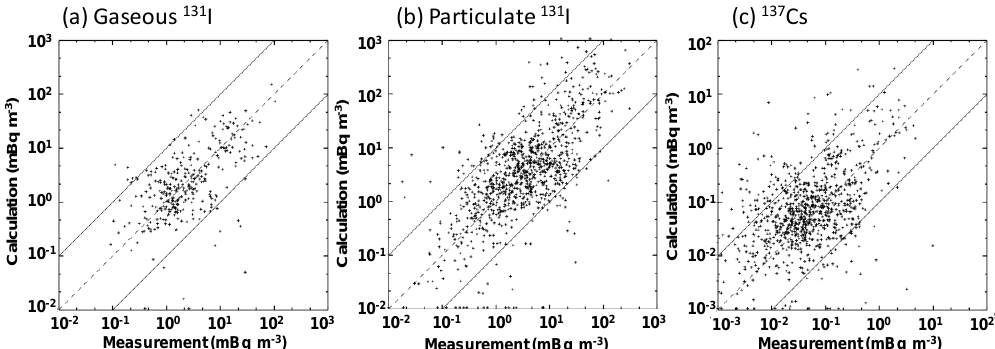
Figure 21. Scatter diagrams of air concentrations (mBqm − 3 ) comparing measurements and calculations using HYSPLIT with the new source term for (a) gaseous and (b) particulate 131 I, and (c) 137 Cs in the CTBTO, US-EPA, and European monitoring stations for the period of 15 March through 20 April. The black dashed lines show the 1:1